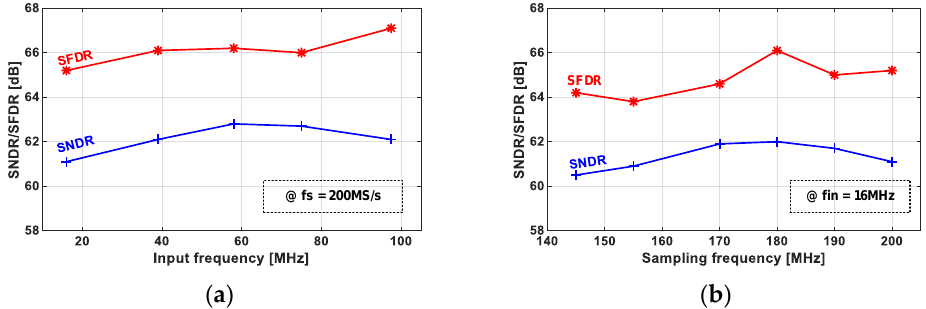
Figure 18. Measured SNDR and SFDR versus: ( a ) various input frequencies at 200 MS/s; ( b ) various conversion rates at 16 MHz. Reprinted with permission from Ref. [22]. Copyright 2019 the Japan Society of Applied Physics. Table 1. Performance comparison. Reprinted with permission from Ref. [22]. Copyright 2019 the Japan Society of Applied Physics.